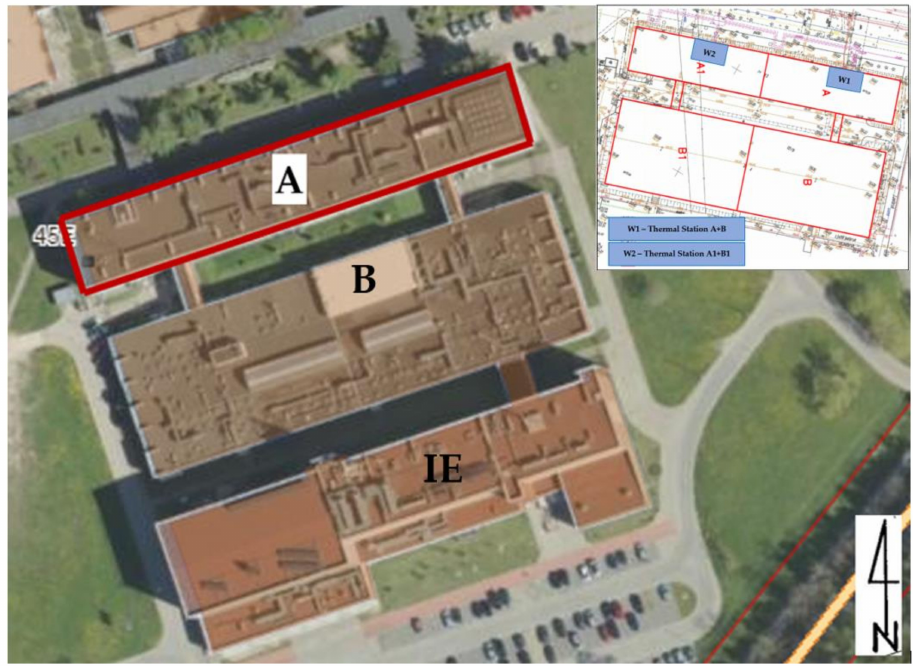
Figure 1. View of the location of the tested building (part A) with the layout of the W1 and W2 thermal substations in the state before modernization